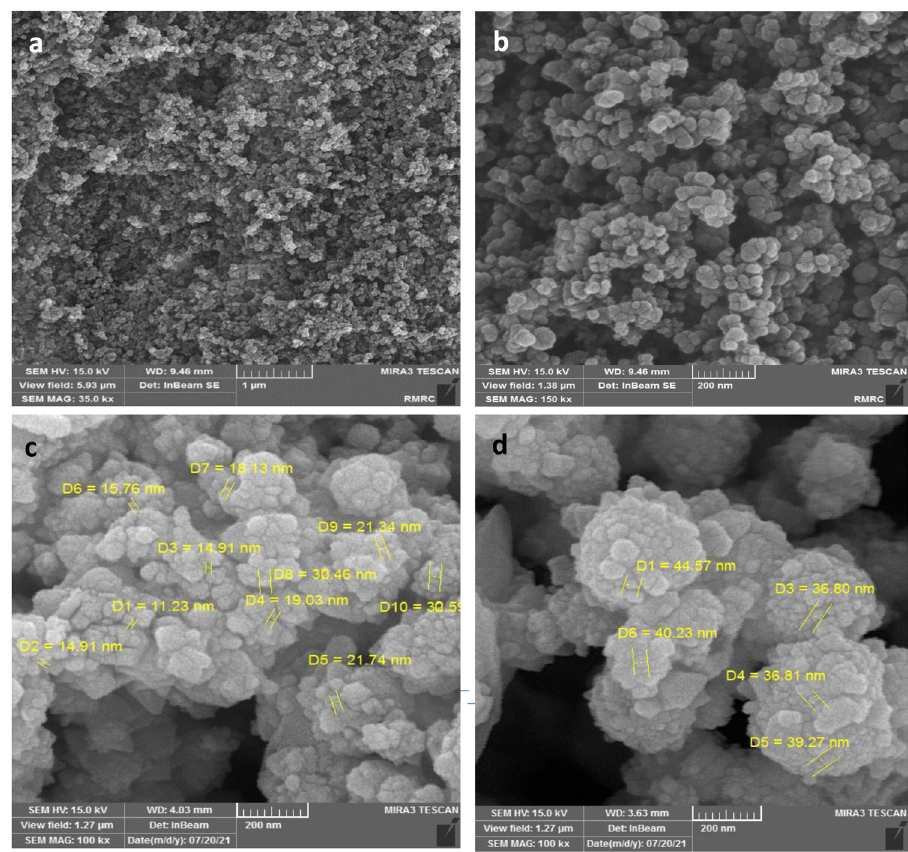
Fig. 1 SEM images of ZnO nanoparticles. a ZnO NPs